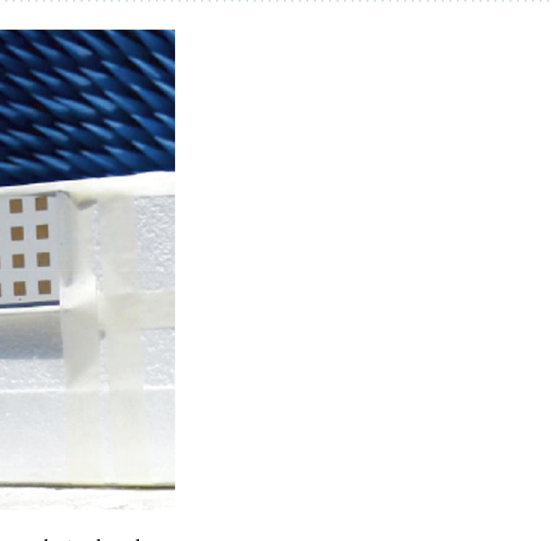
Figure 7. Feed antenna: (a) the 45° view and (b) the down view.